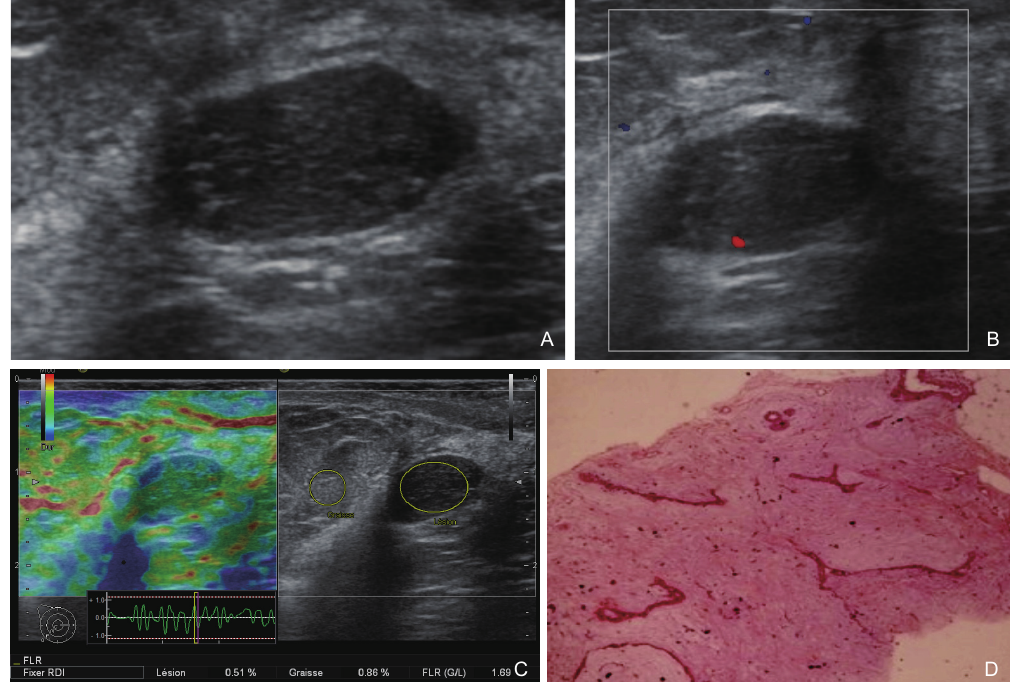
Figure 5 Fibroadenoma in a 41-year-old woman. (A) The B-mode US image shows a breast mass classified as BI-RADS category 3; (B) The color Doppler US image shows low vascularity (Vessels in rim); (C) The strain elastography image shows a strain ratio was 1.69; (D) Pathologic section of the lesion shows fibroadenoma with low stromal